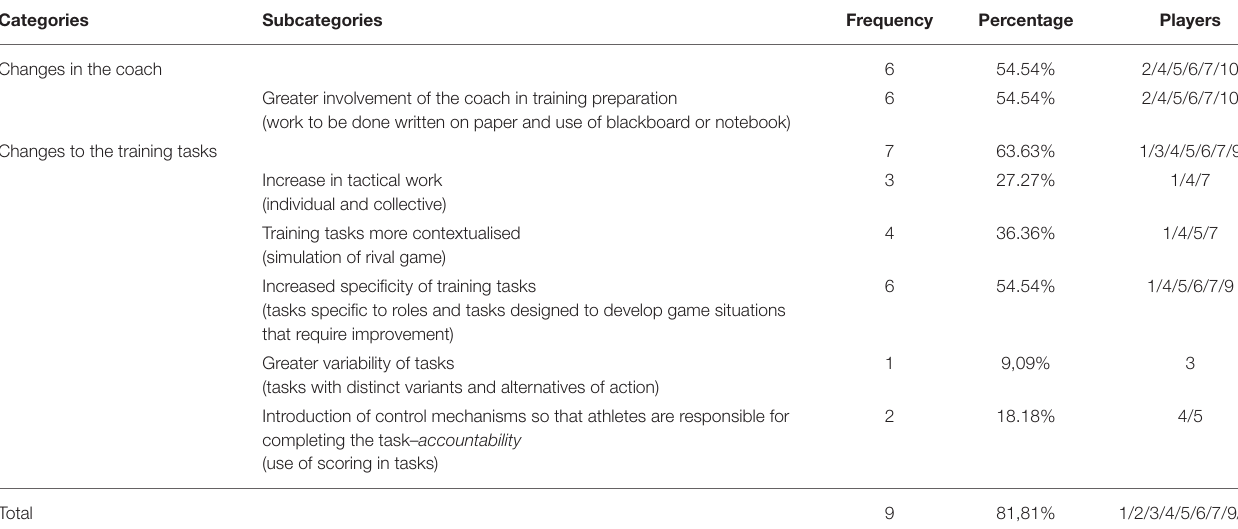
TABLE 5 | Descriptive analysis of the changes and modifications perceived by players in the preparation and development of training.